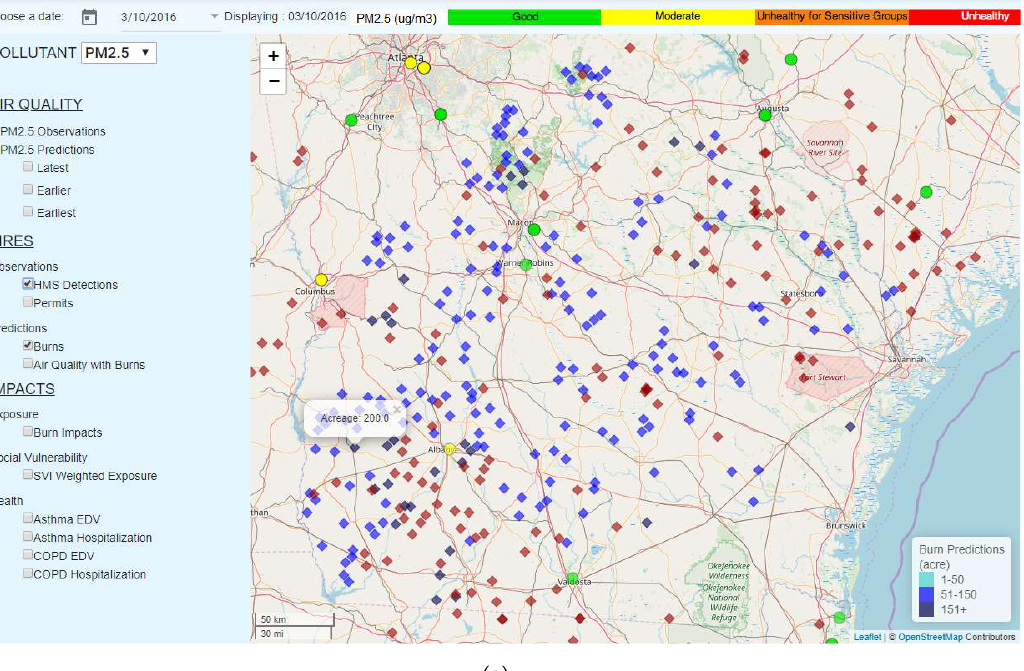
Figure A4. SIPFIS webpage displays forecast burns, overlaid with PM 2.5 forecast levels including the impact of burns.